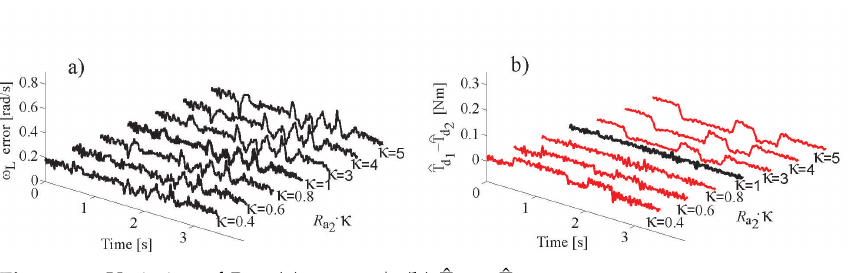
, ( b ) ˆ T d 1 − ˆ T d 2 L